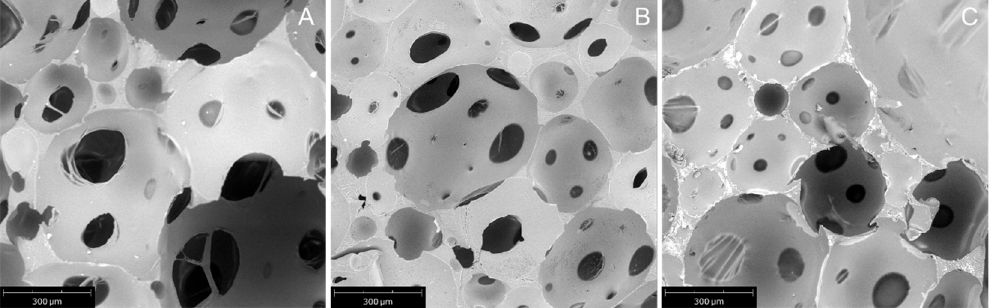
Figure 1. SEM micrographs (magnification 225×) of PUC ( A ), 1_menthol ( B ) and 1_borneol ( C )